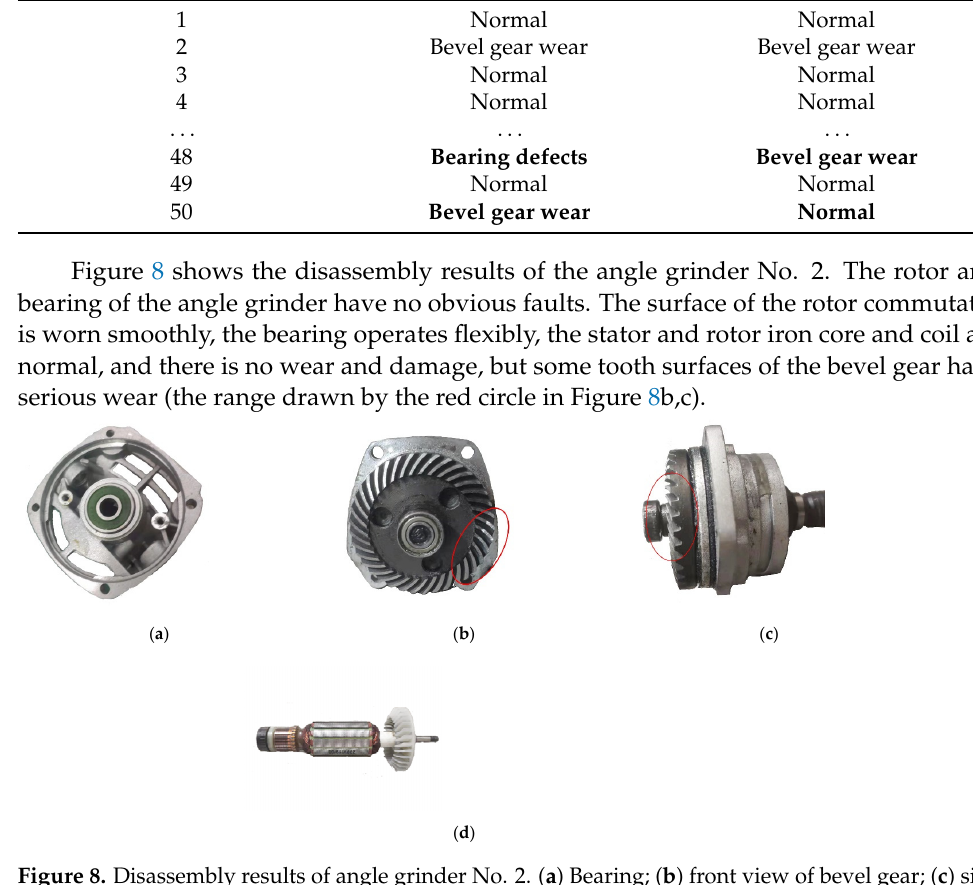
Table 8. Comparison between diagnosis results and actual disassembly results.